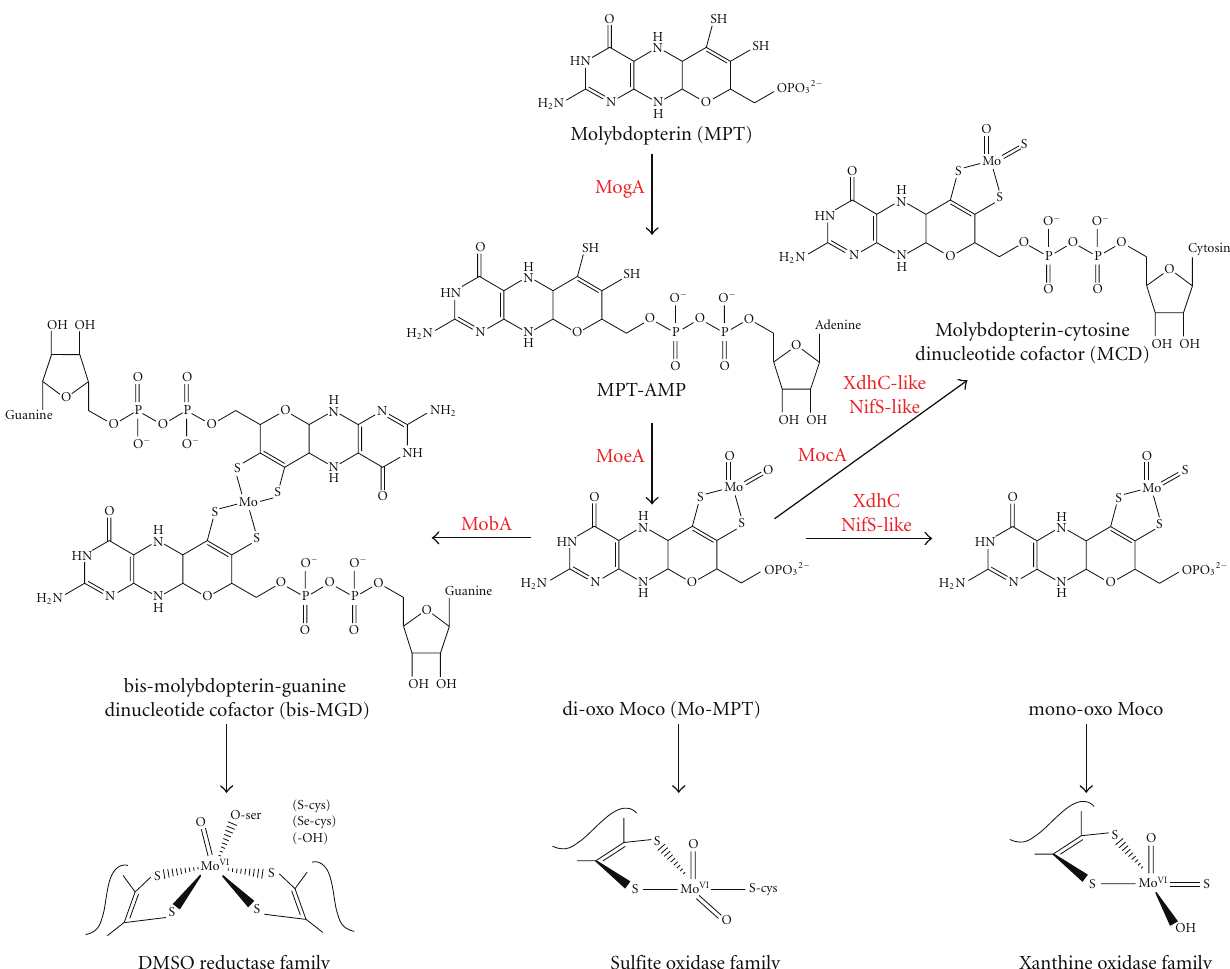
Figure 1: The biosynthesis of Moco and the families of molybdoenzymes. Shown is a scheme of the biosynthetic pathway of Moco from MPT in bacteria. The proteins involved in the reactions are colored red. In bacteria, Mo-MPT can be further modified by the MobA function which attaches GMP to the phosphate group of MPT, forming MGD, and two equivalents of MGD are bound to molybdenum, forming the so-called bis-MGD cofactor. For enzymes of the xanthine oxidase family, Mo-MPT or MCD (which is synthesized by the MocA protein by the attachment of CMP to Mo-MPT) can be modified by the replacement of one oxo-ligand by a sulfur ligand while forming the mono-oxo Moco. This reaction is catalyzed by a NifS-like protein in bacteria. The three molybdenum-containing enzyme families are divided into the DMSO reductase, the sulfite oxidase, and the xanthine oxidase families according to their active-site structures. The molybdenum center is shown in its oxidized state as Mo β . Moco is the general term for all di ff erent variants of the